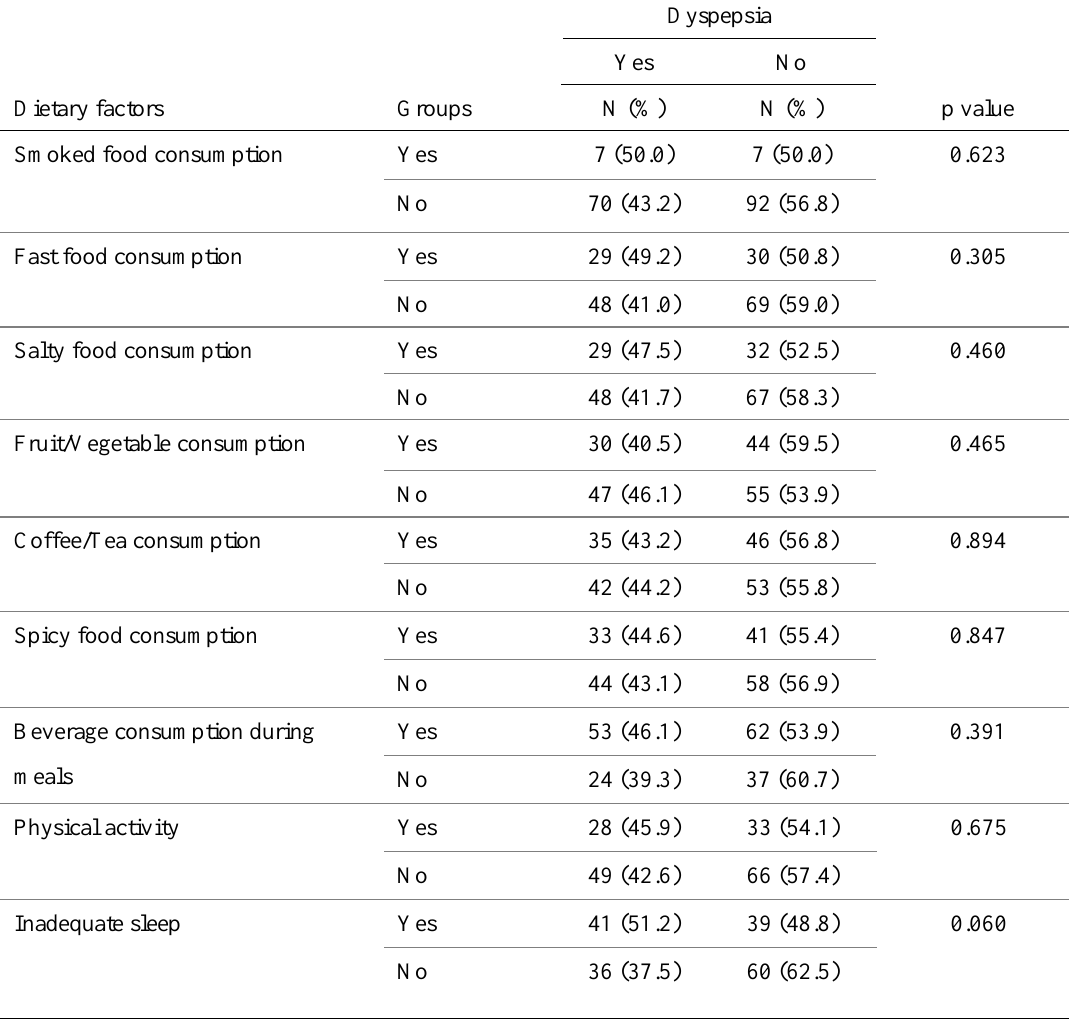
Table 5: Association between dietary factors and dyspepsia Dietary factors